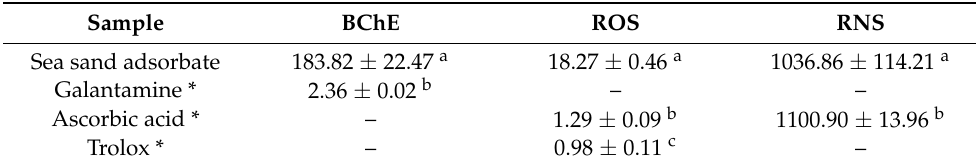
Table 4. IC 50 values ( µ g/mL) from BChE, ROS, and RNS from sea sand (SS)